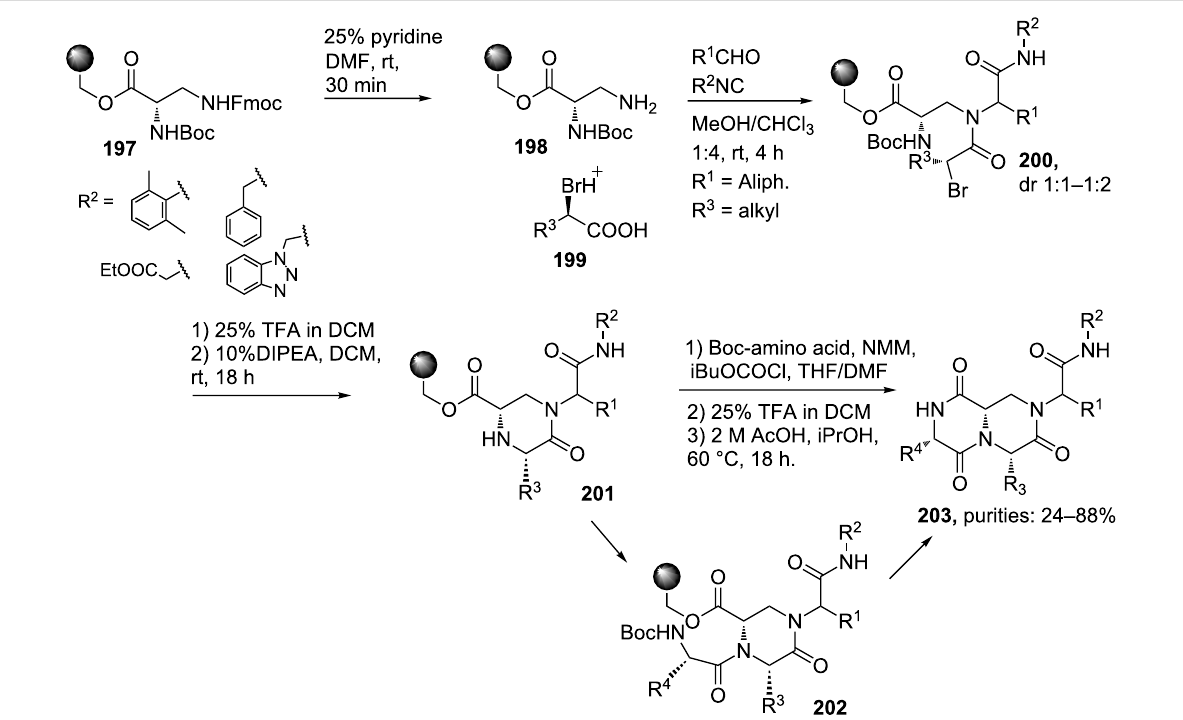
Scheme 60: Ugi-based syntheses of bicyclic DKPs. The amine component is derived from a coupling between ( R )- N -Boc- α - N -Fmoc- L -diaminopropi- onic acid and Merrifield’s hydroxymethyl resin under Mitsunobu conditions, followed by a standard Fmoc deprotection.